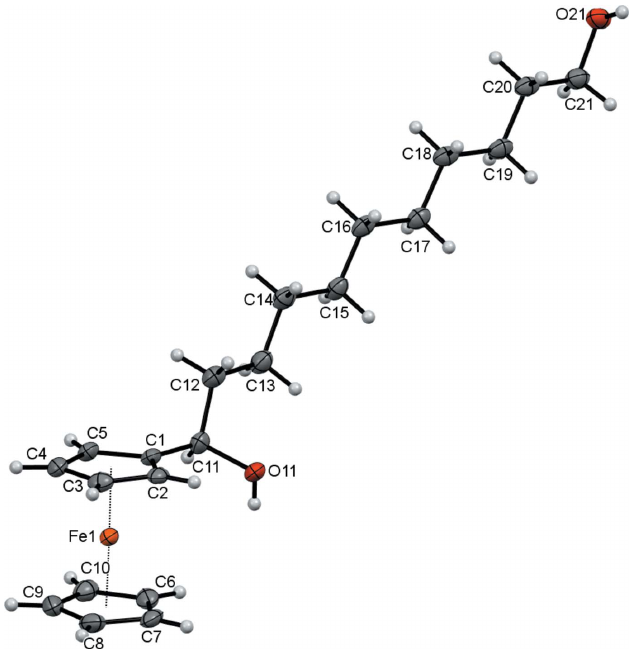
Figure 1 The molecular structure of 1 with ellipsoids drawn at the 50% probability level.